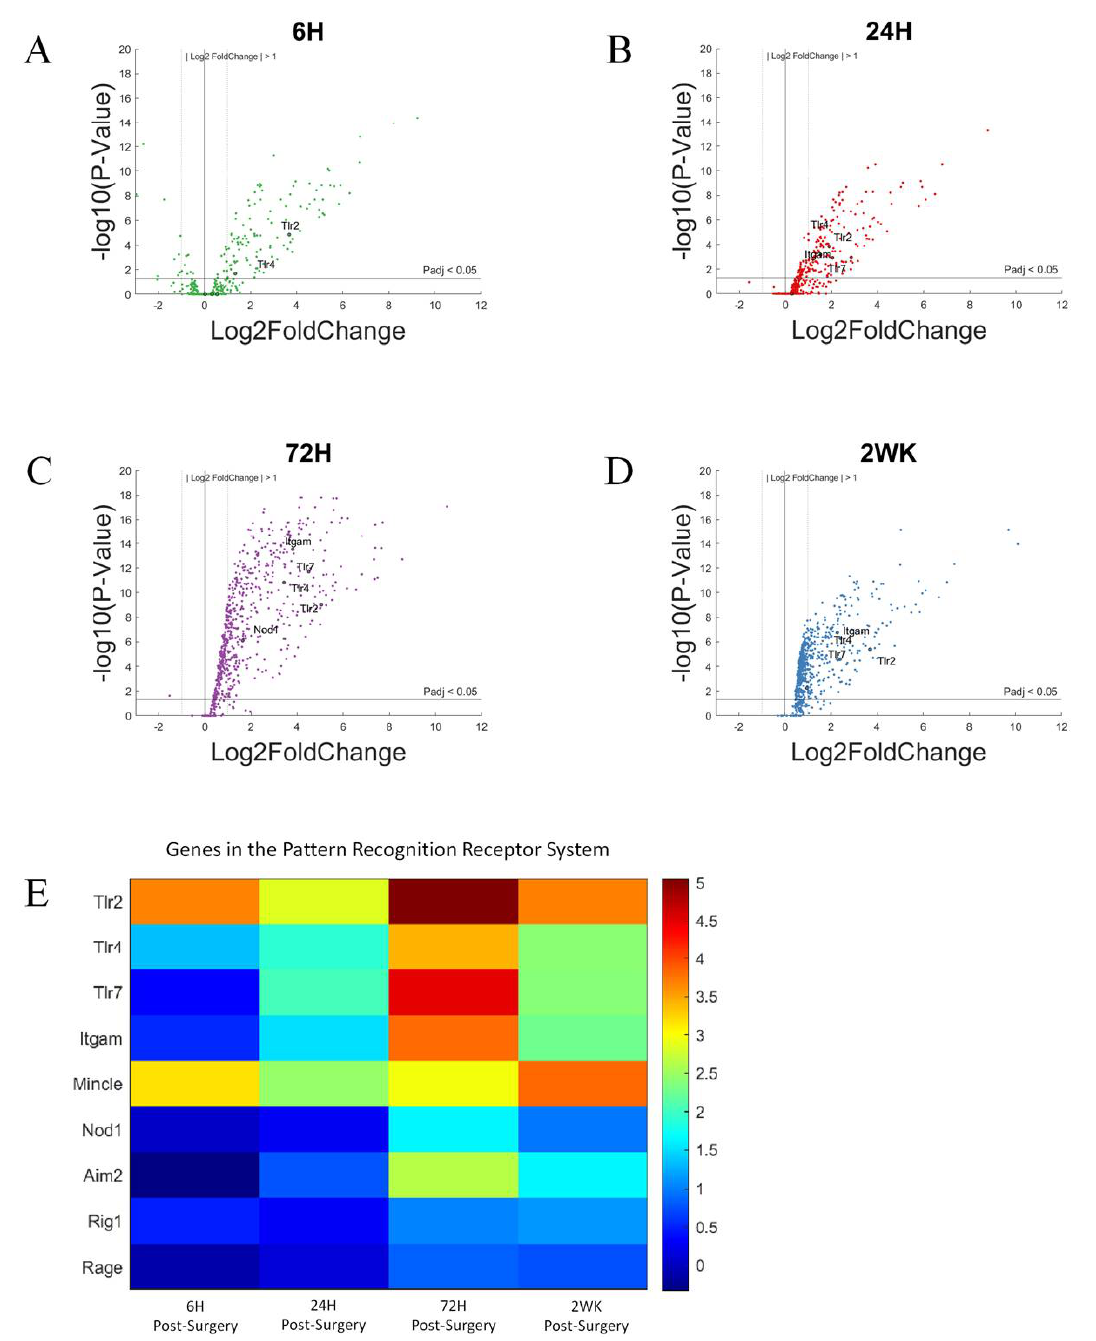
Figure 5. Differential expression of gene set involved in the pattern recognition system compared to NSCTR mice: ( A ) volcano plot with genes in the PRR pathway are shown in black. Genes in the pattern recognition system with P adj < 0.05 and log2foldchange > 1 or < − 1 are labeled. Each time point post-surgery is on a separate volcano plot. ( A ) =6-h, ( B ) =24-h, ( C ) =72-h, and ( D ) =2-weeks. Color in ( A – D ) corresponds to time post-surgery color coding in other figures. ( E ) heatmap showing differential expressions of genes of the chemokine system at each time point post-surgery compared to